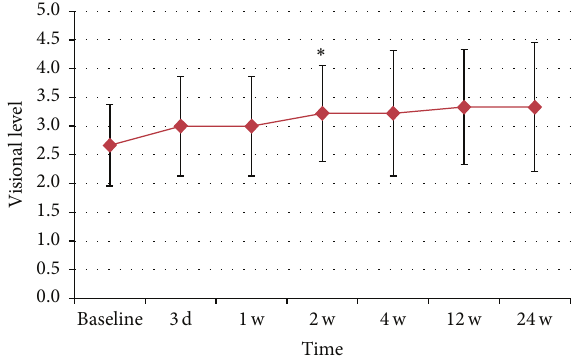
Figure 4: Changes of visual level since baseline to 6 months after operation. The GEE analysis showed that average visual level improved after the operation, peaked at 2 weeks ( 𝑃 < 0.05 ), and kept stable in the following 6 months ( 𝑃 > 0.05 ). Visual acuity (VA) was stratified into the following categories: no light perception was scored as 0, light perception was scored as 1, hand motion perception was scored as 2, finger count perception was scored as 3, ≥ 20/400 was scored as 4, and ≥ 20/200 was scored as 5 [17]. ∗ The change of VA was significant from baseline to 2 weeks after the operation.